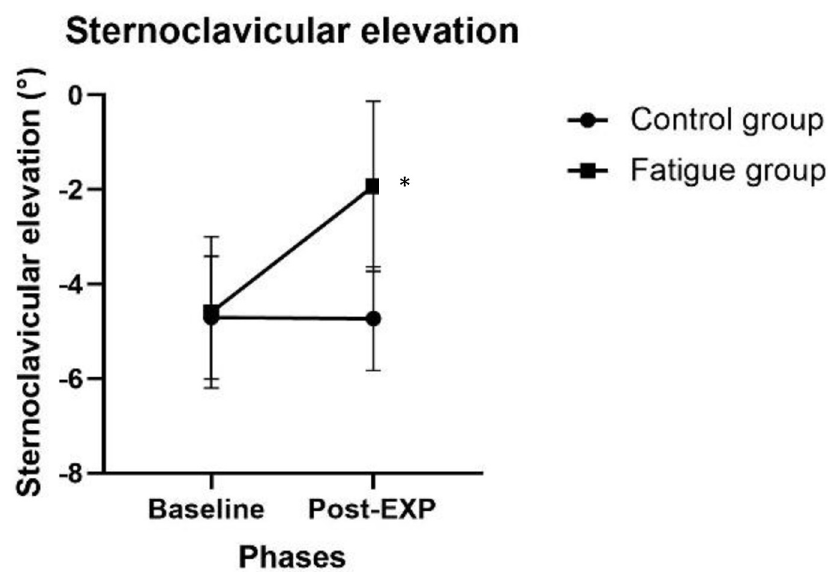
Fig 1. Sternoclavicular elevation initial position. Post EXP: Post-experimental phase. Results are presented as mean values for the 4 targets (SD) of the initial sternoclavicular elevation. Significant Time x Group interaction for the initial sternoclavicular elevation: The Fatigue group showed higher sternoclavicular elevation during the Post-experimental phase compared to the Baseline phase ( p < .05).